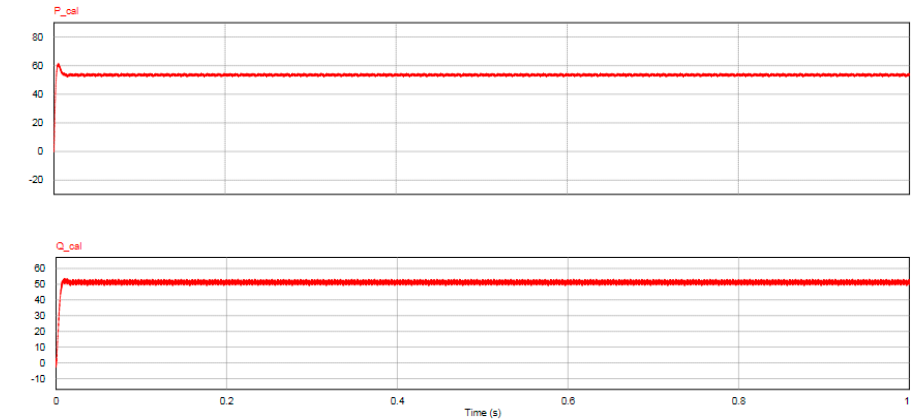
Figure 15. For mode-1 inverter 1 output (fed by battery).